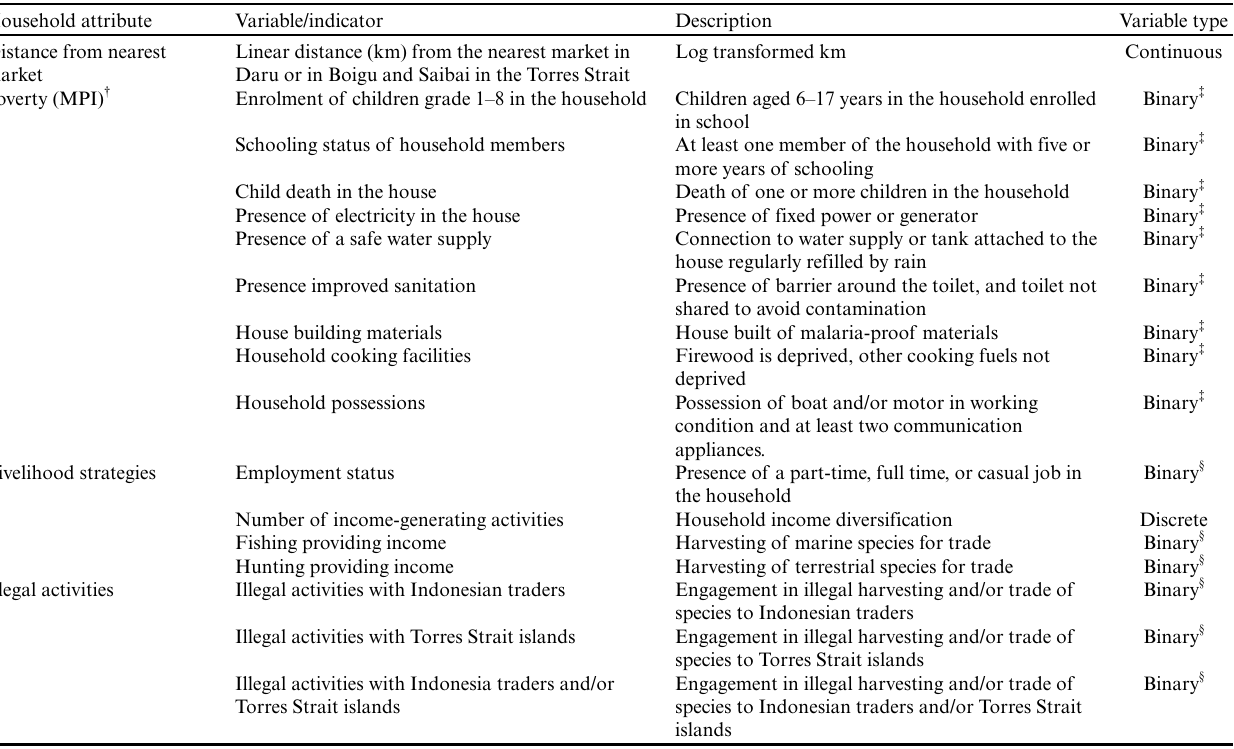
Table 1 . Household attributes used to analyze relationships between illegal activities, poverty, distance to market, and livelihood